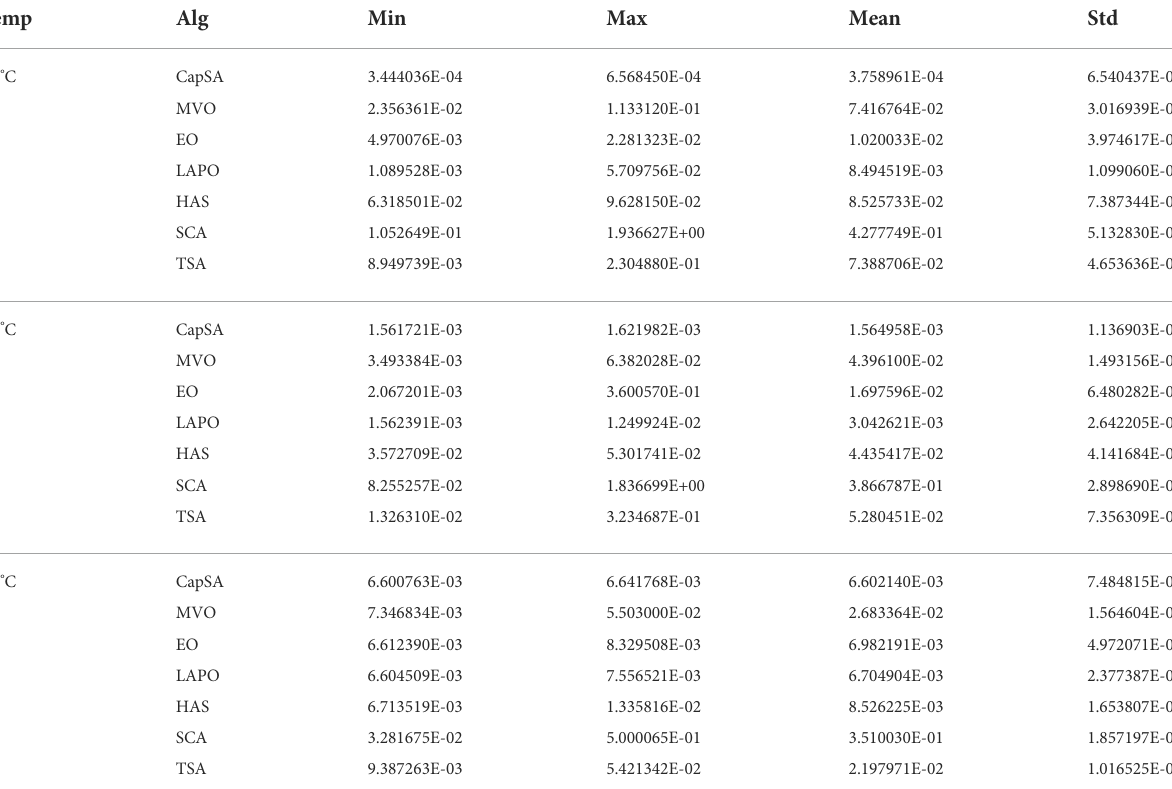
TABLE 11 Statistical parameters of the optimizers applied on KC200GT at different temperatures.